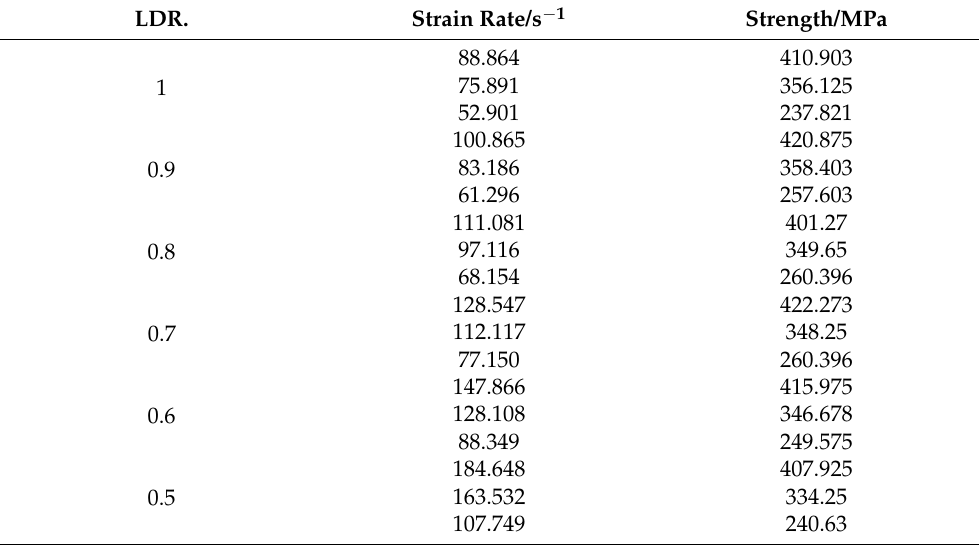
Table 1. Dynamic loading mechanical parameters of specimens. LDR.